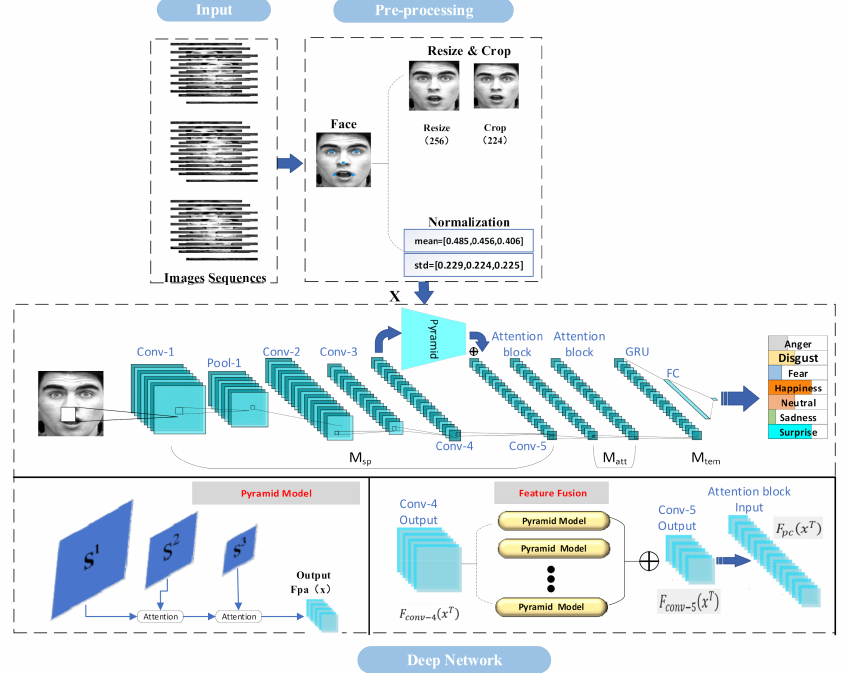
Figure 1. The architecture of the cascade attention-based facial expression recognition network